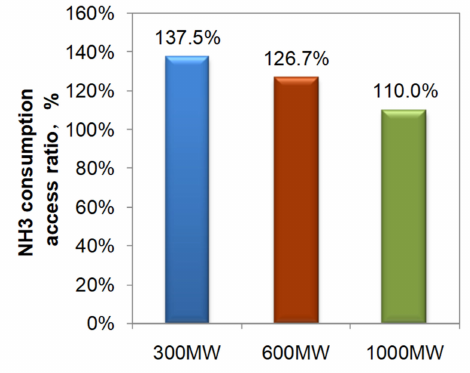
Figure 1. Statistics data of the average ammonia excessive ratio of selective catalytic reduction (SCR).